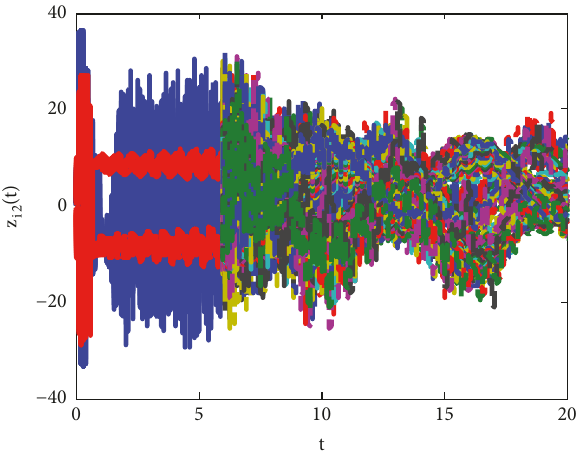
Figure 3: (Color online) Evolution patterns of community network 𝑧 (𝑡) with 𝑡 . 𝑖2